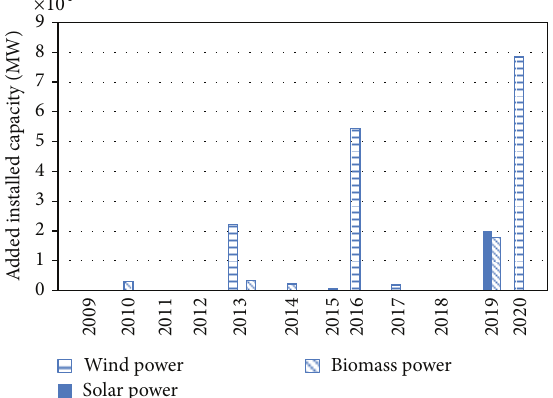
Figure 3: The added installed capacities of three renewable sources of